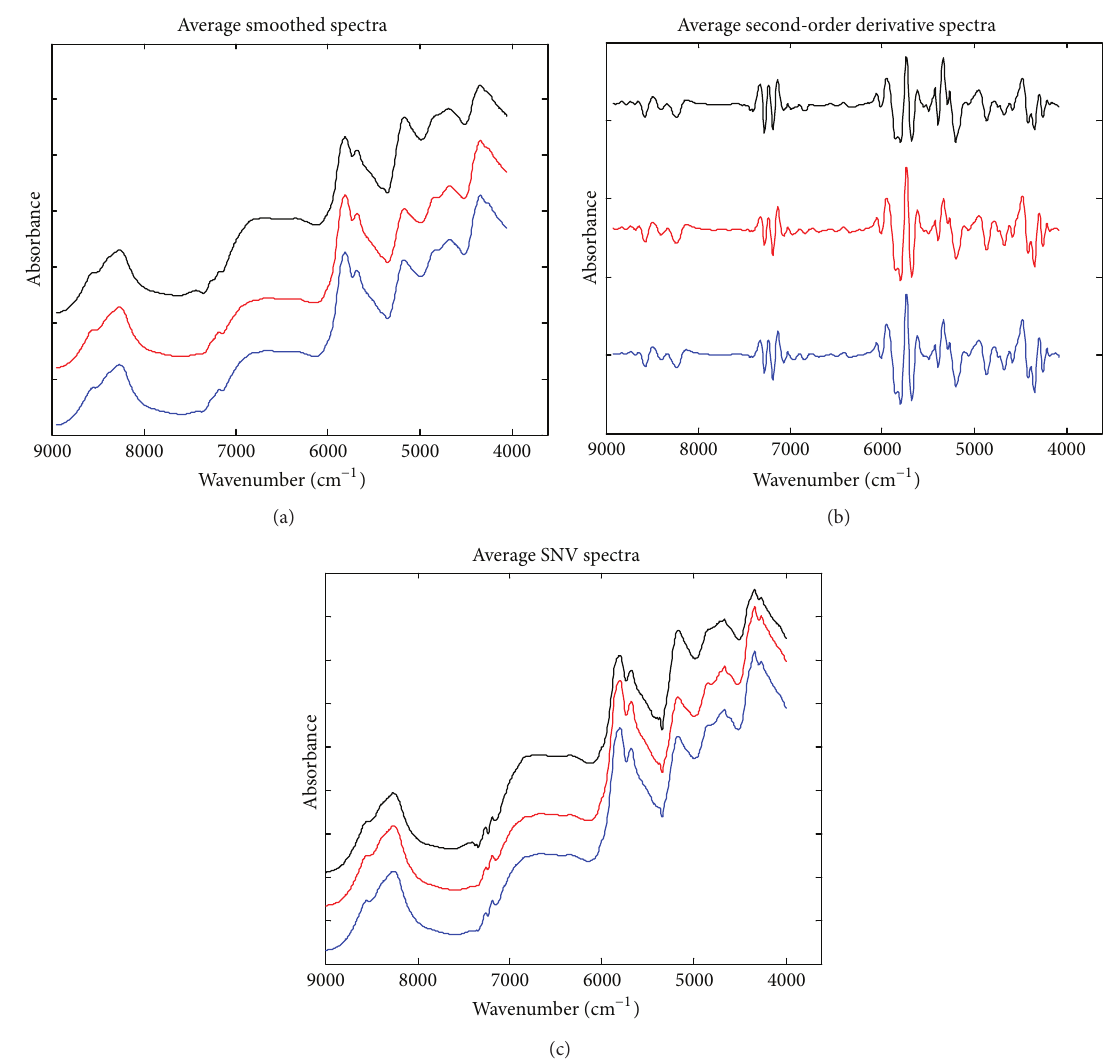
Figure 4: Average preprocessed spectra of different classes of T. grandis seeds by smoothing, taking second derivatives, and SNV transfor- mation; old Fengqiao (blue), fresh Fengqiao (red), and fresh non-Fengqiao